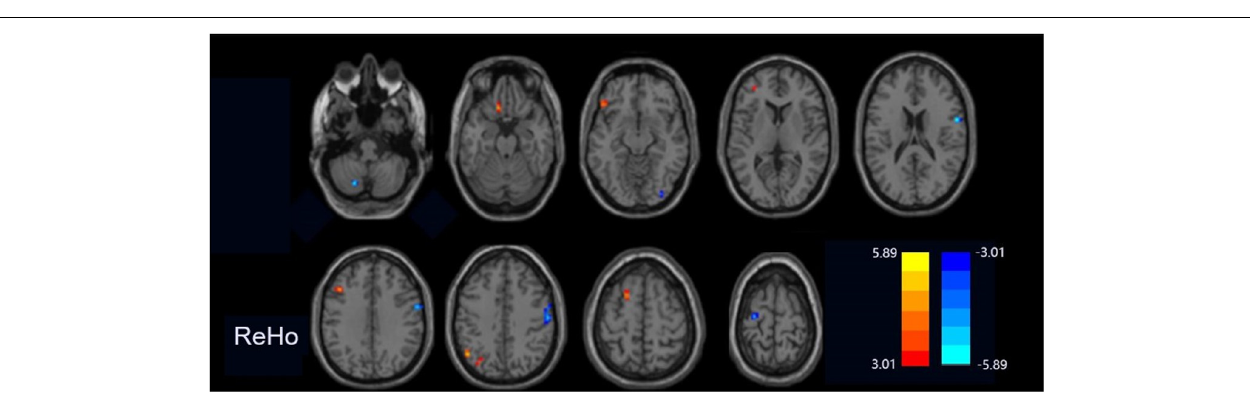
FIGURE 2 | Regions exhibiting differences in ReHo between peripartum depression and healthy postpartum women (p < 0.005 corrected by FDR). The warm colors represented the significance of higher ReHo values and the cool colors represented the significance of lower ReHo values for the group